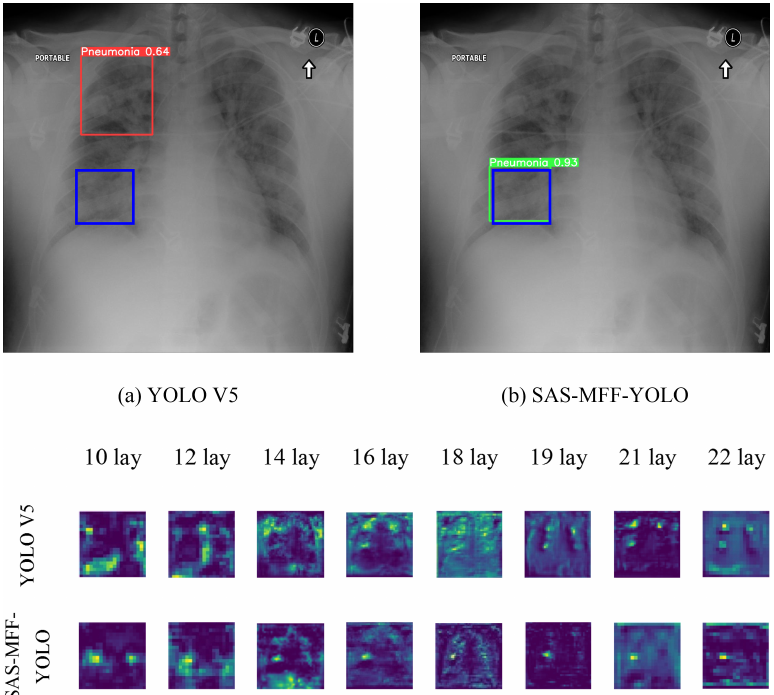
Figure 6. An example of feature maps visualization. ( a , b ) are the results of lesion detection produced by YOLOv5 and SAS-MFF-YOLO, respectively. The blue bounding boxes are the ground truth, while the red and green ones were labeled by the two models. The heat maps show the selected feature maps.